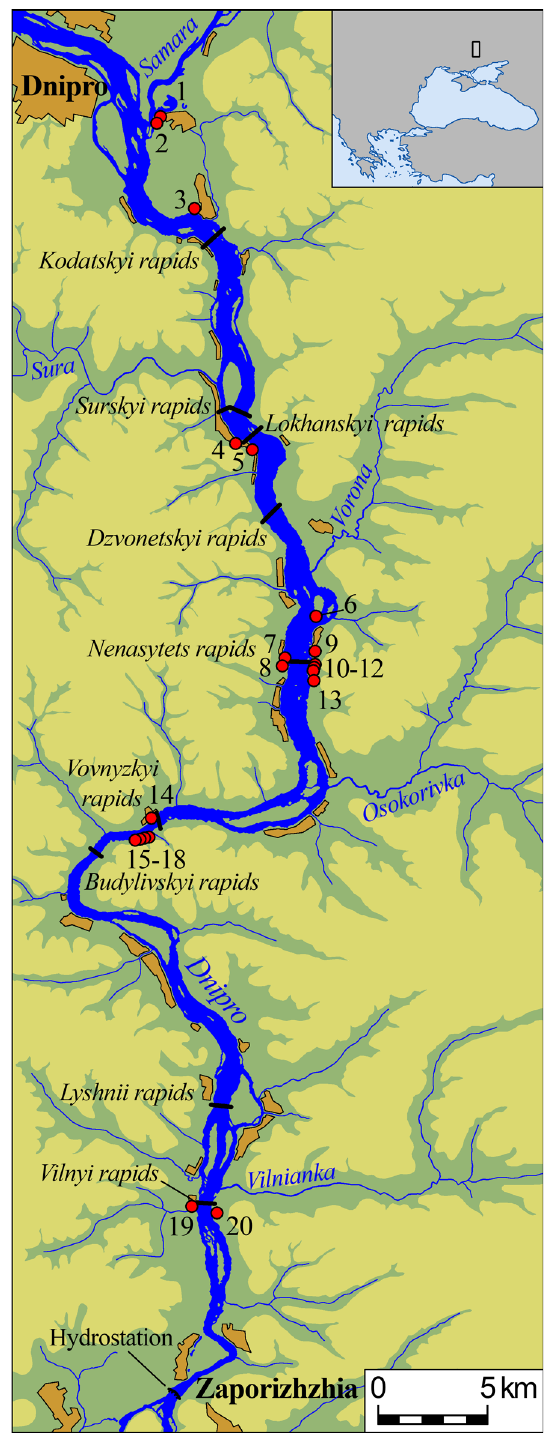
Figure 1: Schematic map of the Dnipro Rapids region ( before 1931 ) with the Mesolithic and Neolithic sites mentioned in